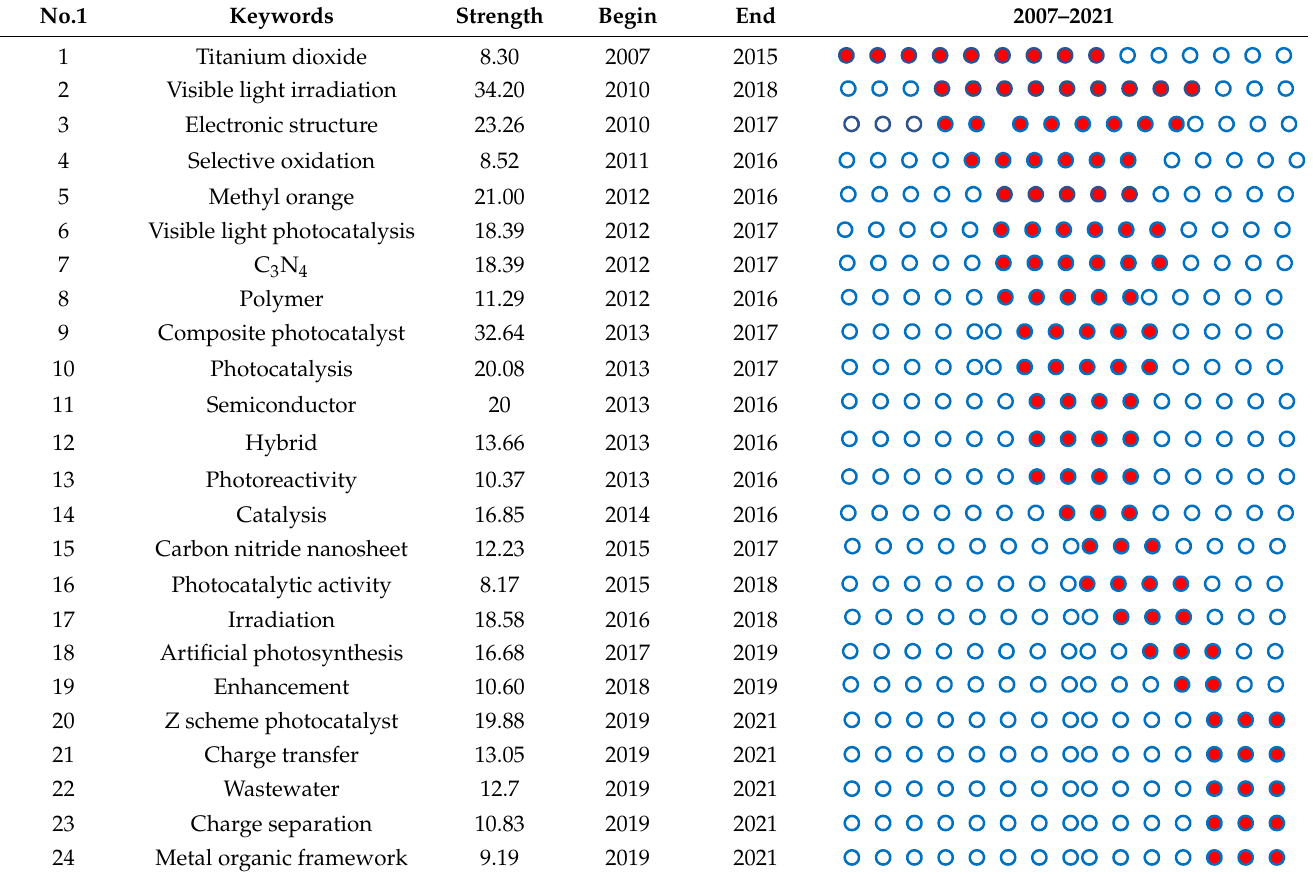
Table 4. The top 24 keywords with the highest outbreak intensity.